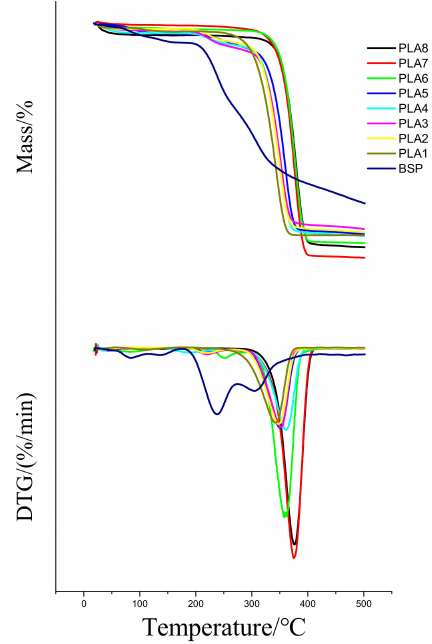
Figure 4. TG and DTG Curves of Composite Films. Temperature / thermogravimetry and Temperature / di ff erential thermogravimetry